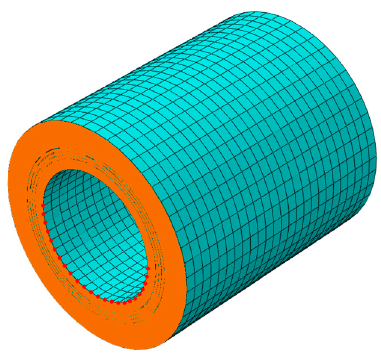
Figure 10. The contact pressure on the nodes marked with red color are collected.